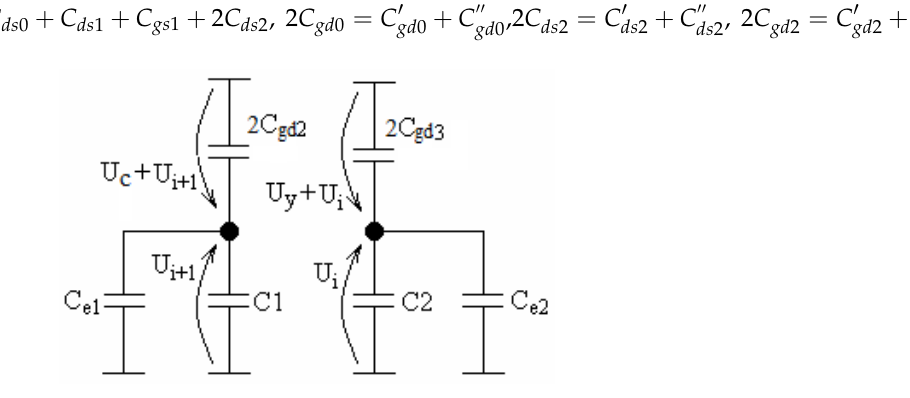
Figure 3. A model of the LADC with successive approximation on switched capacitors which takes into account parasitic charge transfer.